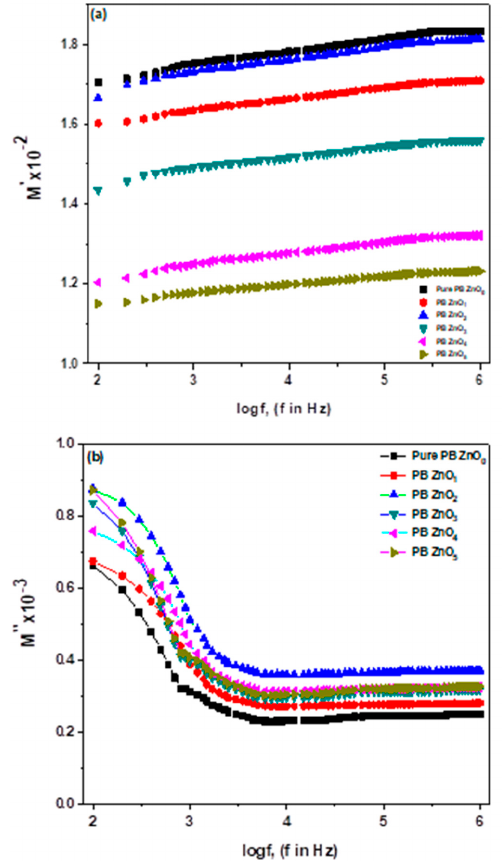
Figure 11. ( a , b ): ( a ) Real part of electric modulus ( M ′ ), ( b ) Imaginary part of electric modulus (M ″ ) versus frequency for samples at room temperature.